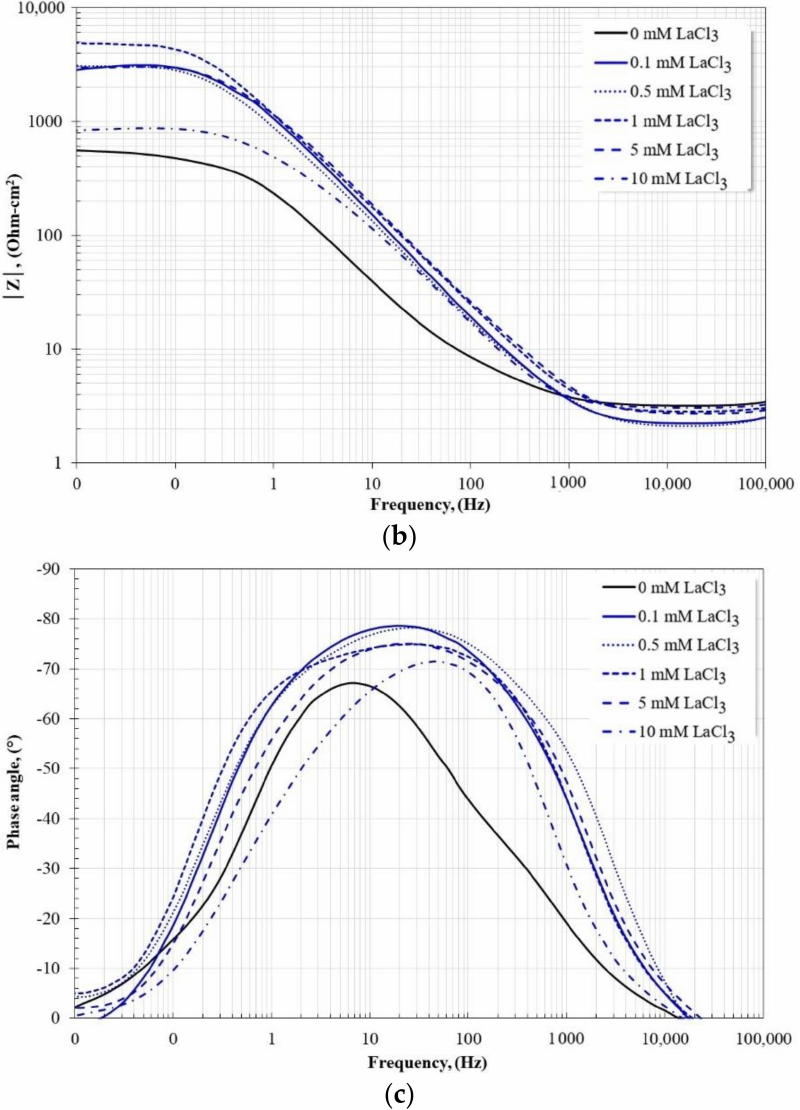
Figure 5. Nyquist and Bode diagrams for 1018 carbon steel in CO 2 -saturated brine at different concentrations of lanthanum chloride after 50 h of immersion. ( a ) Nyquist diagram; ( b ) Bode diagram in its impedance modulus format; ( c ) Bode diagram in its phase angle